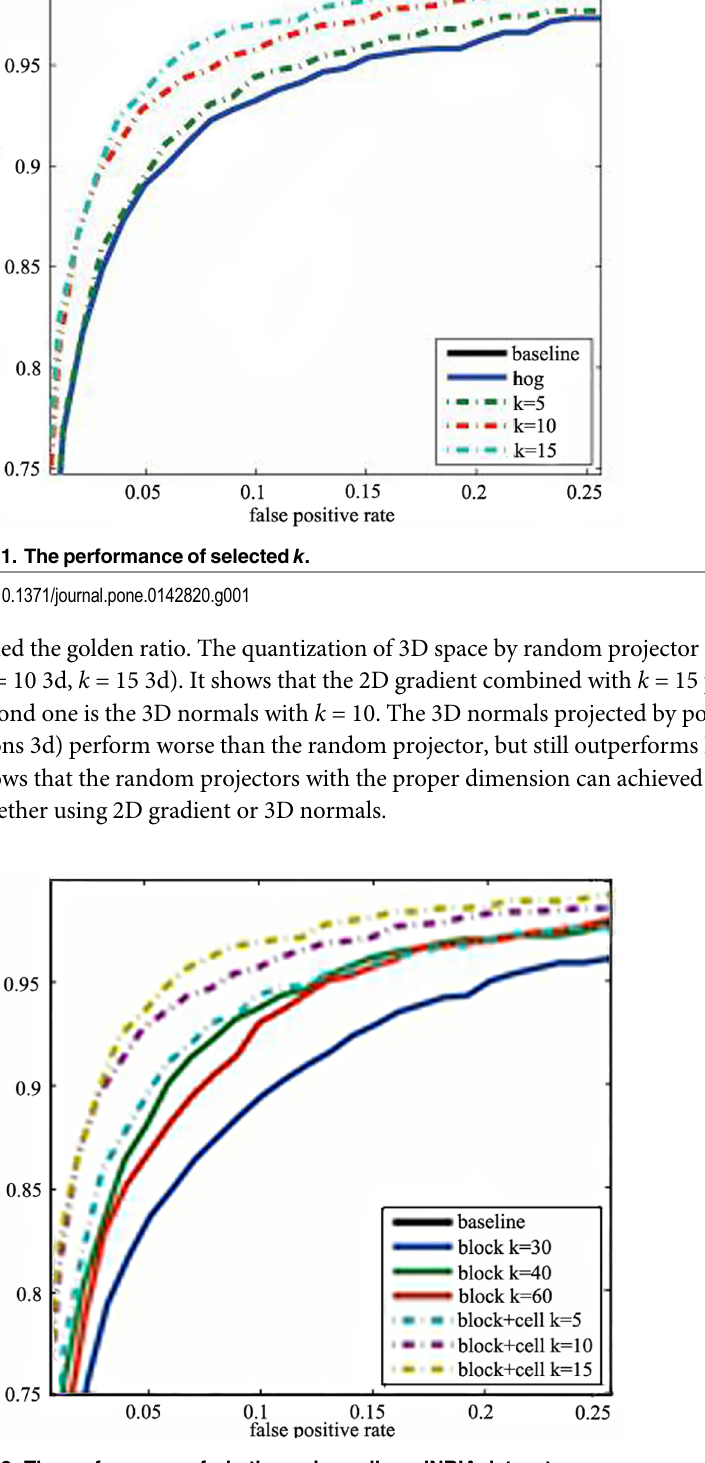
Fig 2. The performance of whether using cells on INRIA